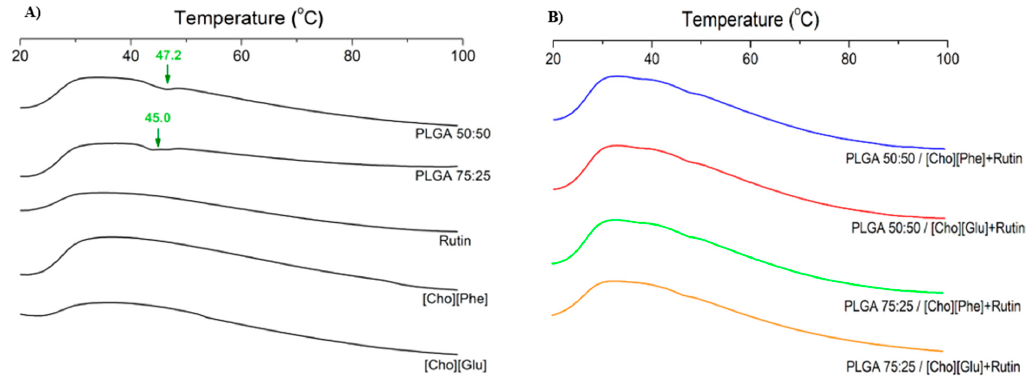
Figure 4. DSC thermogram of controls (PLGA 50:50, PLGA 75:25, rutin, [Cho][Phe] and [Cho][Glu]) ( A ), rutin-loaded IL-PLGA nanoparticle hybrid systems ( B ), all obtained after freeze-drying.